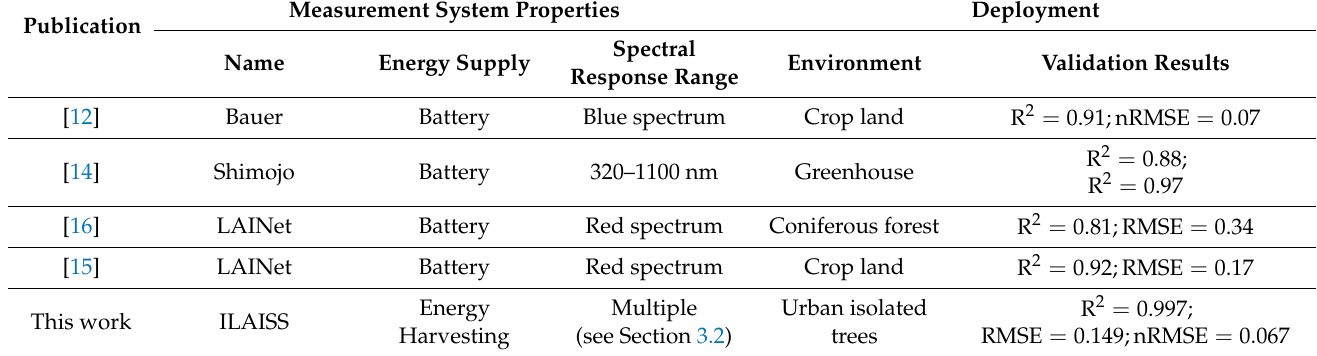
Table 2. Overview about the properties of the automatic LAI measurement systems and validation results that were achieved in indoor and outdoor